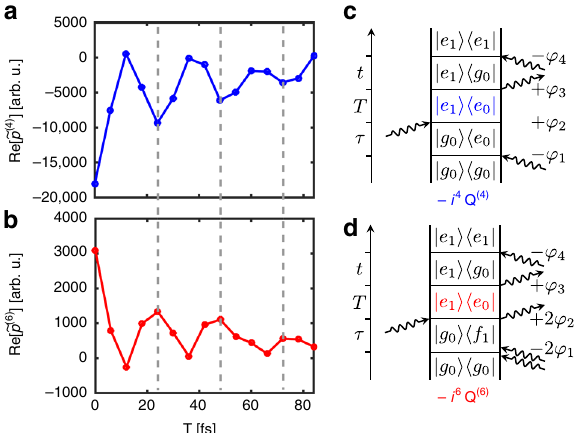
Fig. 6 Comparison of fourth- and sixth-order 0Q coherence signatures of TIPS – TAP 2 − in THF. a Real part of a cross-peak transient of the rephasing 1Q – 0Q – 1Q contribution ( ~ p (4) ) at ( ℏ ω τ , ℏ ω t ) = (2.06, 2.23eV), along with c a respective double-sided Feynman diagram. b Real part of a cross-peak transient of the rephasing 2Q – 0Q – 1Q contribution ( ~ p (6) ) at ( ℏ ω τ , ℏ ω t ) = (4.27, 2.23eV) with d a respective double-sided Feynman